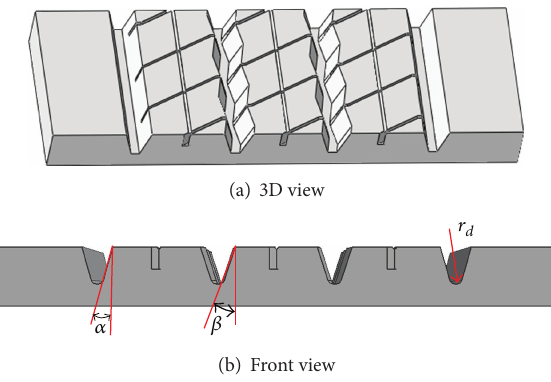
Figure 8: 3D model of tread block specimen.